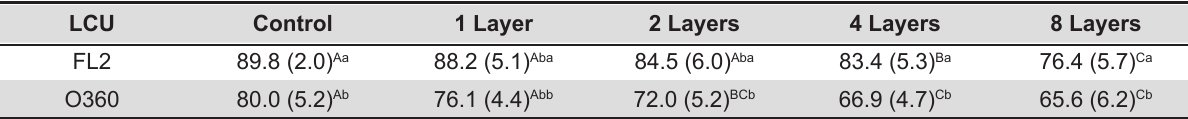
Table 3- Hardness ratios (standard deviations) of composite resin specimens light cured with light curing units covered with layers of an infection control barrier